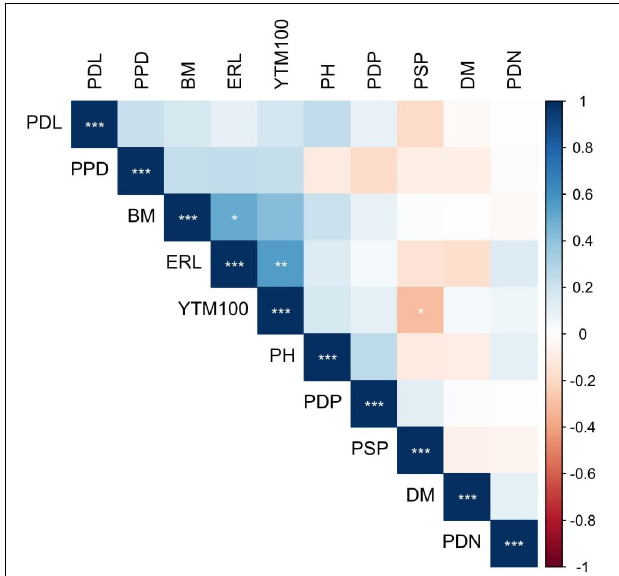
FIGURE 3 | Person’s correlation coefficient and level of significance between best linear unbiased prediction (BLUP) estimated values of agronomic and downy mildew (DM) resistance traits of wrinkled vining pea genotypes. * P < 0.05, ** P < 0.01, *** P <